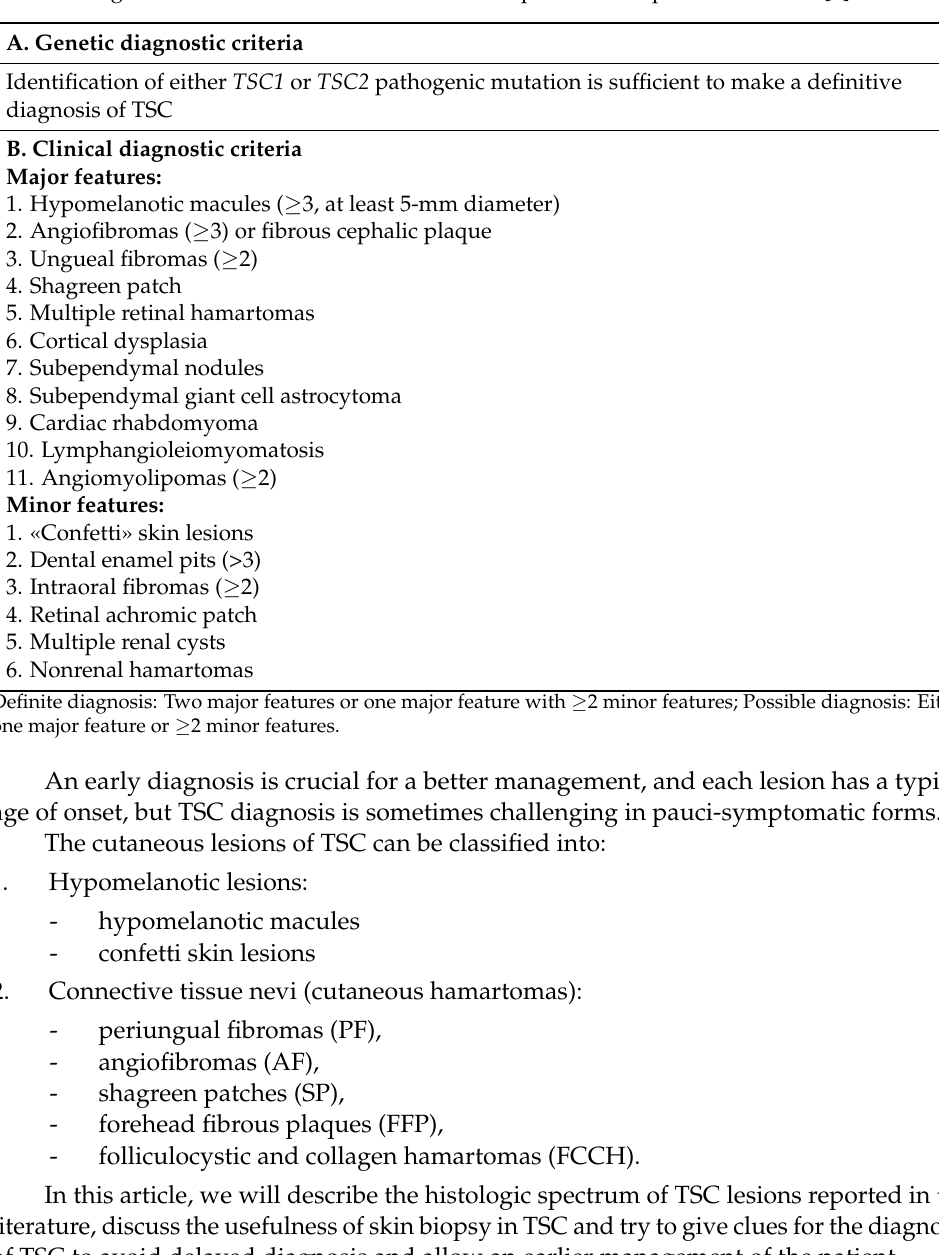
Table 1. Diagnostic criteria for tuberous sclerosis complex 2012. Reprinted from ref.